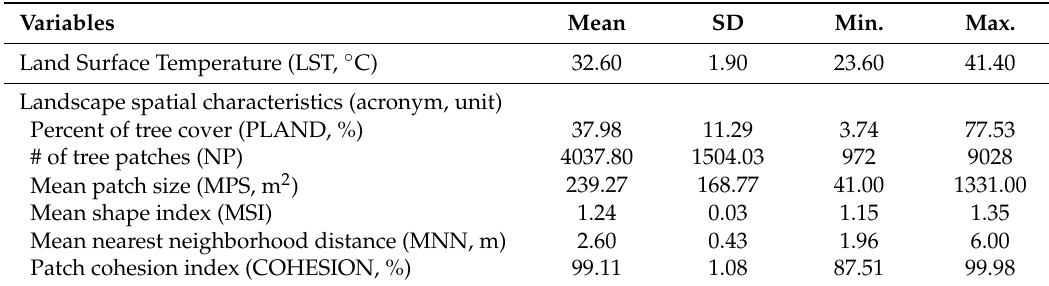
Table 3. Summary statistics ( n =